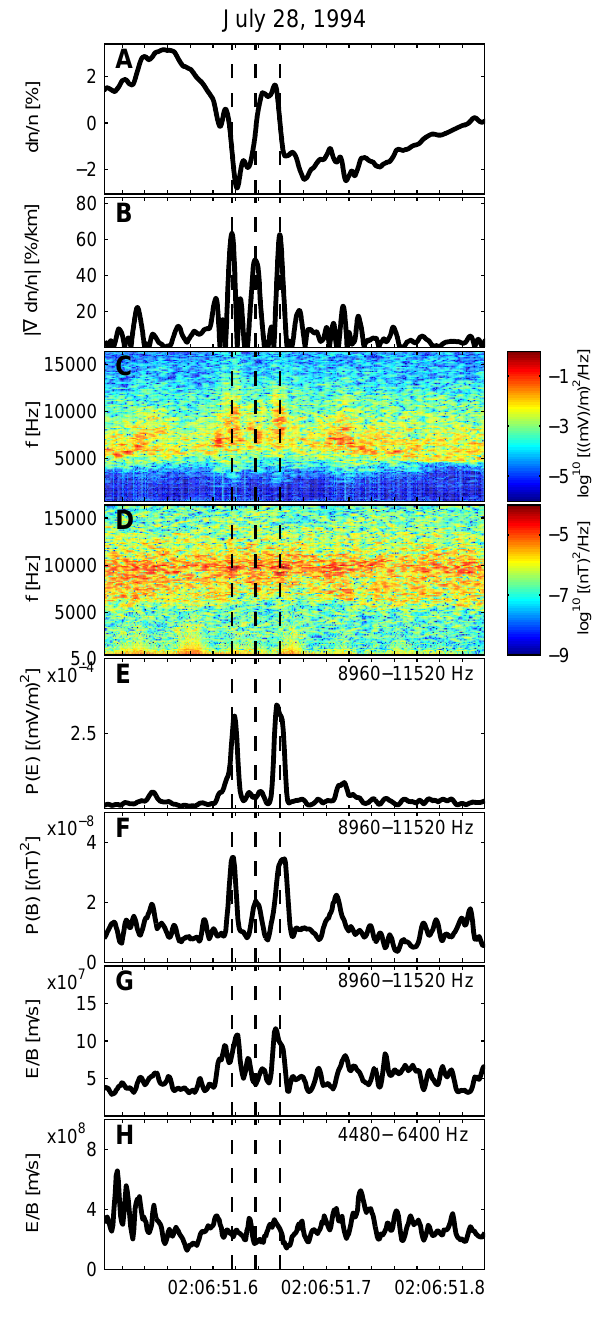
Fig. 3. Panel A shows the density profile. Panel B displays the ab- solute value of the gradient of the density. We assume spatial struc- Fig. 3. Panel (A) shows the density profile. Panel (B) displays the tures and the gradient is given in %/km. The electric and magnetic absolute value of the gradient of the density. We assume spatial power spectral densities are plotted versus time and frequency in structures and the gradient is given in %/km. The electric and mag- panels C and D. The electric and magnetic wave powers in the fre- netic power spectral densities are plotted versus time and frequency quency range 8960–11520 Hz are given in panels E and F. Panels G in panels (C) and (D) . The electric and magnetic wave powers in the and H present E/B for the two frequency intervals 8960–11520 Hz frequency range 8960–11520 Hz are given in panels (E) and (F) . and 4480–6400 Hz. Panels (G) and (H) present E/B for the two frequency